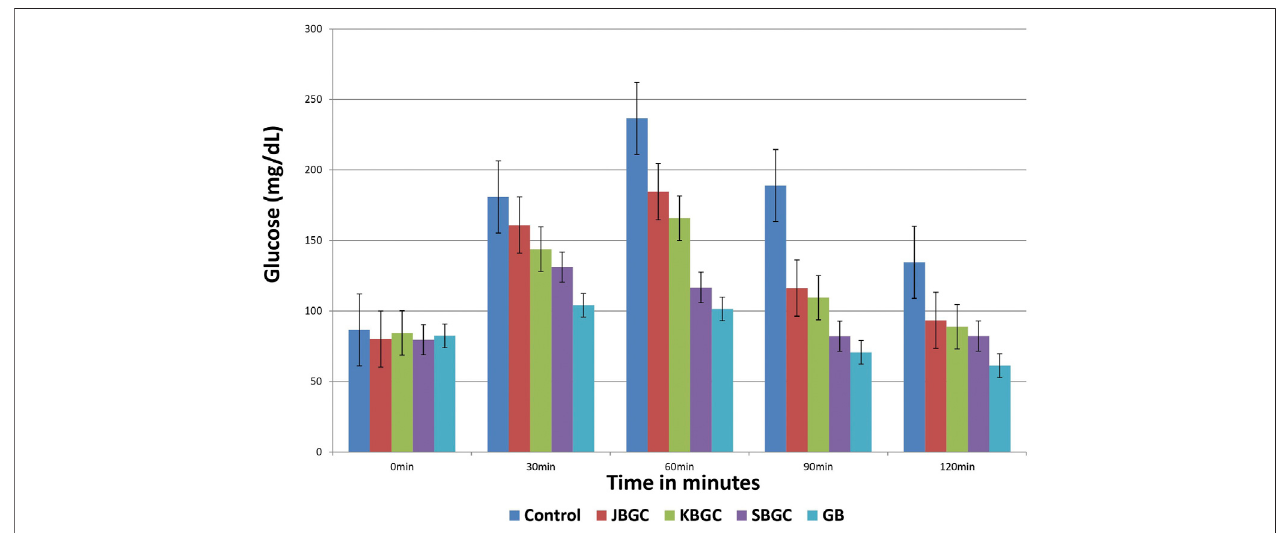
FIGURE 7 | Effect of Svarasa Bhavita Guduchi Churna (SBGC), Kwatha Bhavita Guduchi Churna (KBGC), and Jala Bhavita Guduchi Churna (JBGC) on BSL in glucose overloaded mice.